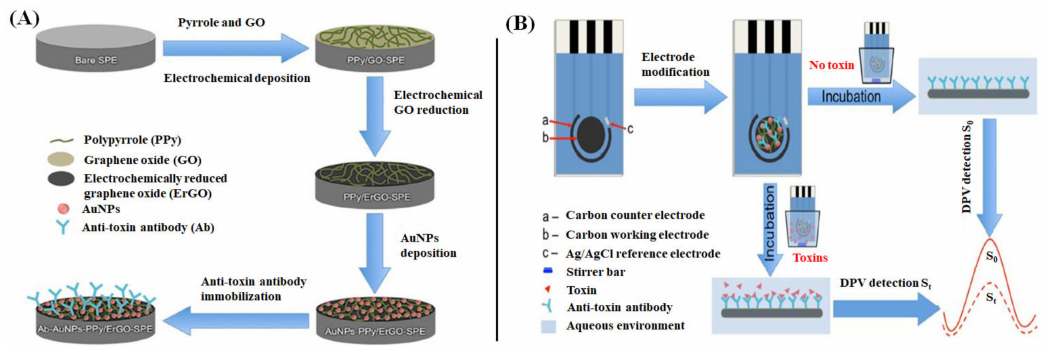
Figure 3. ( A ) Demonstration of step-by-step fabrication of the GO-based biosensor (antibody-Au NPs- polypyrrole/electrochemically reduced GO-screen printed carbon electrode) and ( B ) electrochemical immunosensing of the system employed for the detection of mycotoxins through DPV signals